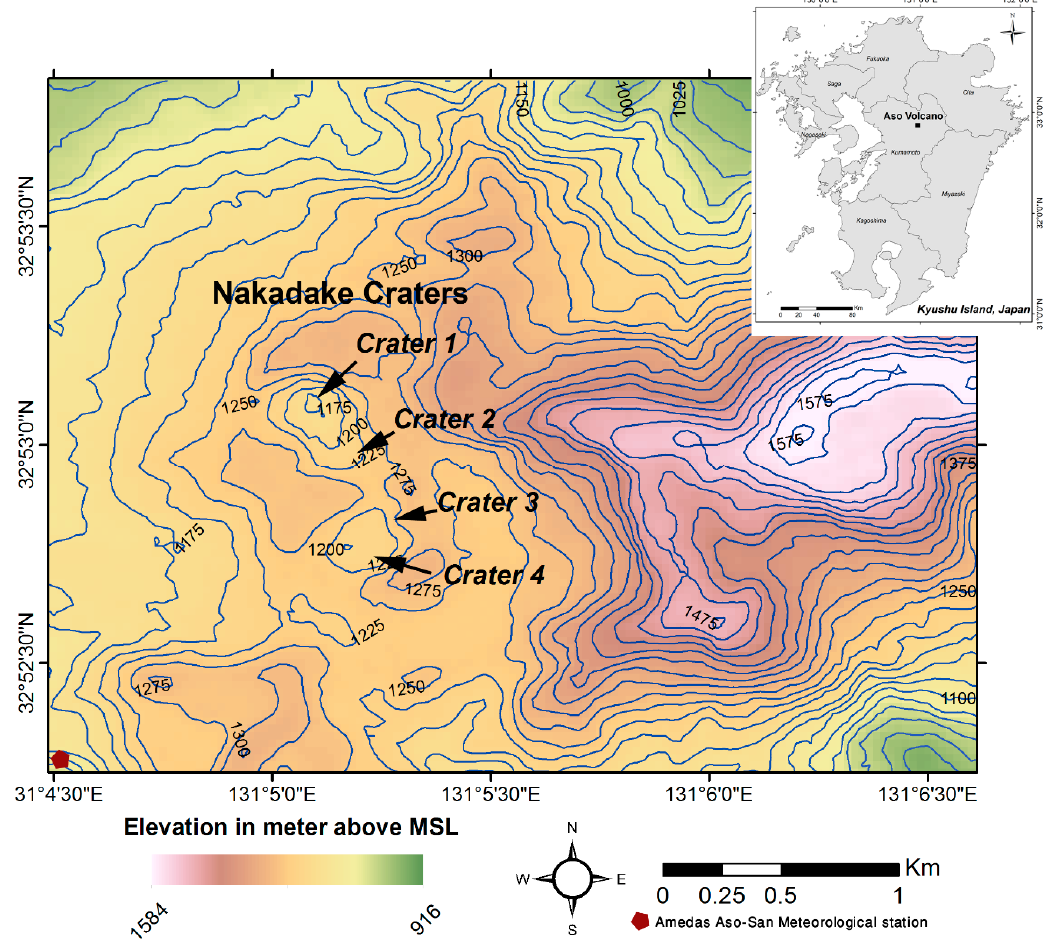
Figure 1. Location map of the study. It shows the Aso volcanic area with spatial elevation data above mean sea level as contour lines. Nakadake consists of four active craters in this volcano, shown as Craters 1, 2, 3, and 4.